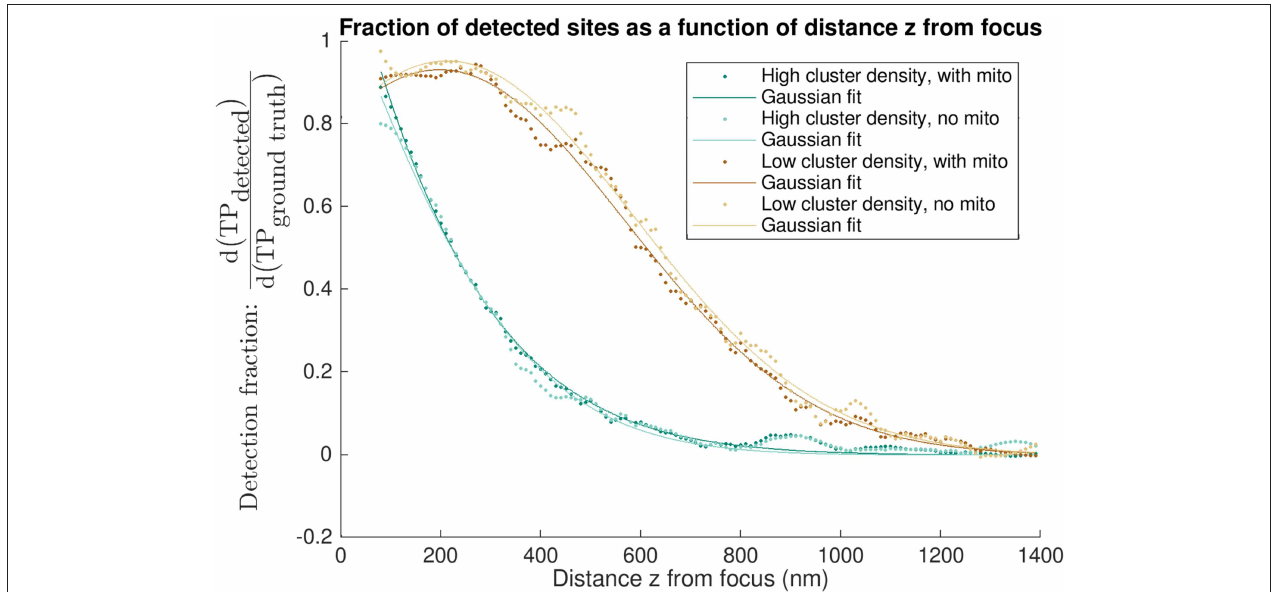
FIGURE 7 | “Differential recall”: axial dependence of detection of true positive sites. Each curve shows the fraction of detected sites as a function of the distance z from the nominal focal plane. Differential recall at distance z is the fraction of all detected to modeled sites within 5 nm of that z depth i.e., within a 10 nm band centered about the distance z above and below the focal plane. A value of 1 is equivalent to the detection of all sites at a given z-depth. The various curves are calculated for different models, having a high or low density of sites and either using homogeneous diffusion (“no mito”) or obstacles to diffusion wherever mitochondria are (“with mito”). Data points shown are the result of applying a smoothing filter (see Figure S5 for the low density, no mito case shown in light brown). Solid lines indicate single-term Gaussian fits to the filtered